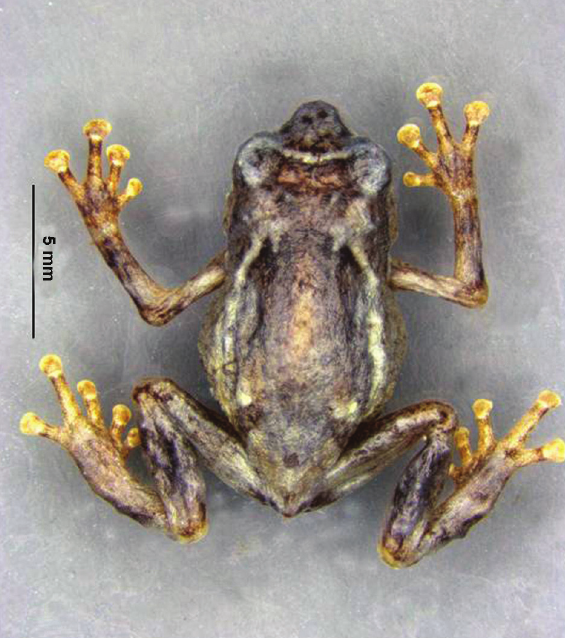
Figure 11a. Preserved holotype of Choerophryne bisyllaba sp. n. in dorsal view.